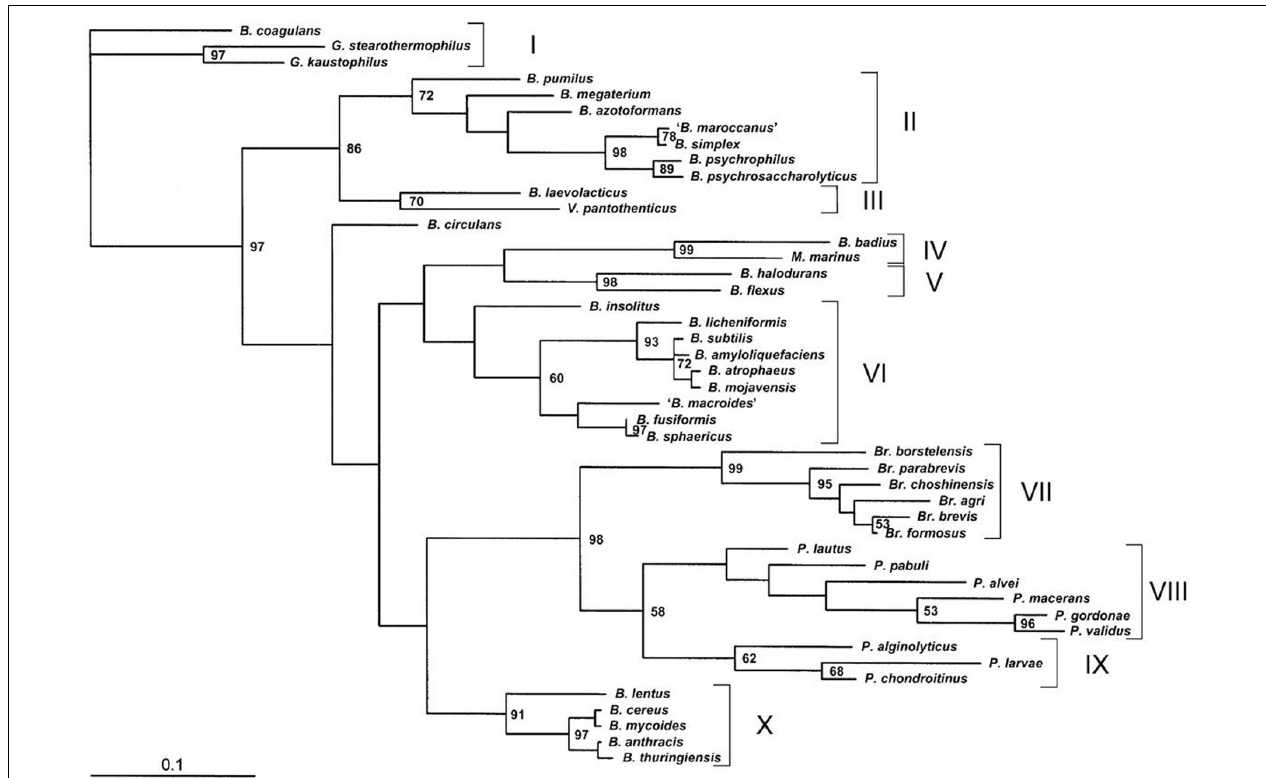
FIGURE 3 | Phylogenetic relationships of 46 Bacillus species. The bar represents the unit length of the number of nucleotide substitutions per site (adopted from Xu and Cote,